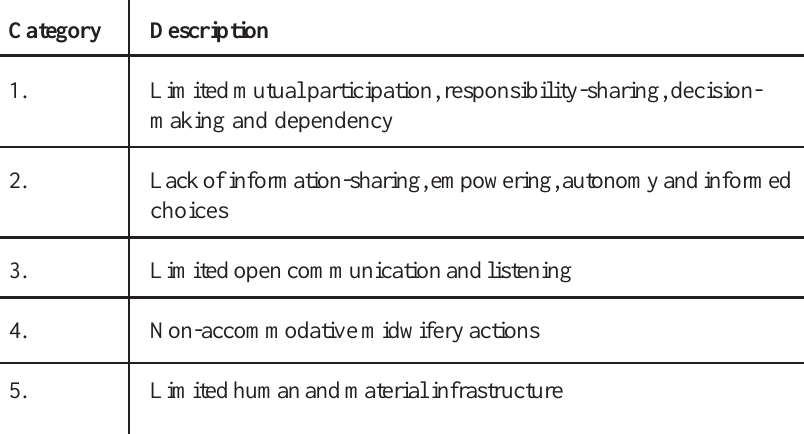
Table 1: Categories that emerged from analysis of midwives’ experiences of managing women who are in